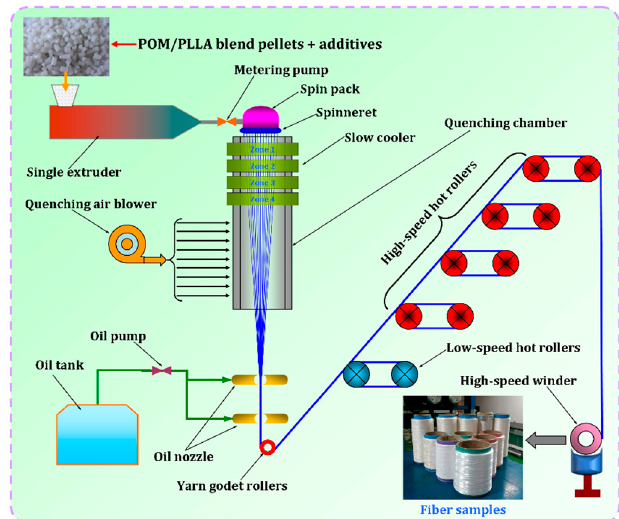
Figure 1. Schematic representation of melt-spinning and post-drawing processes for POM/PLLA bicomponent fibers.